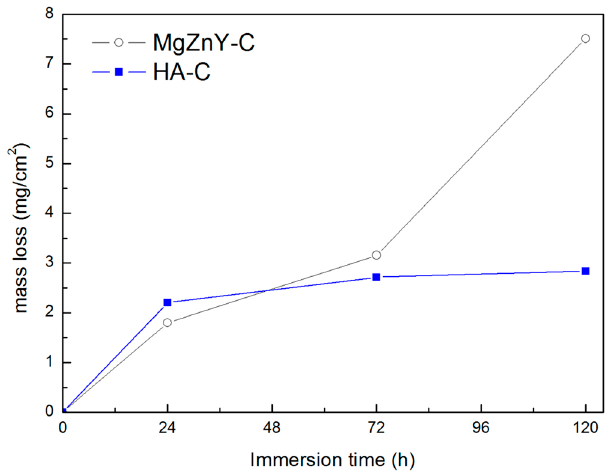
Figure 8. Mass losses of MgZnY-C and HA-C alloys as a function of immersion time.